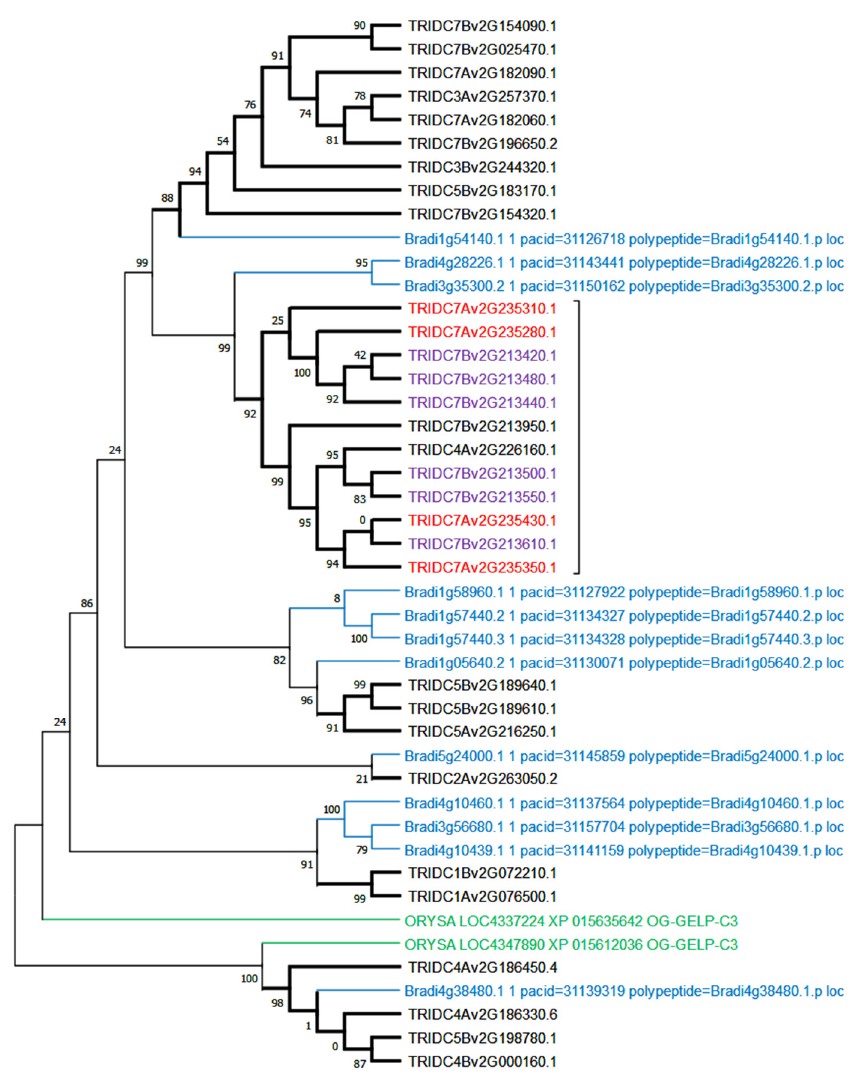
Figure 4. OG-GELP-C3 member amplification in T. durum . The phylogenetic tree was constructed with sequences of T. durum , B. dystachion and O. sativa .